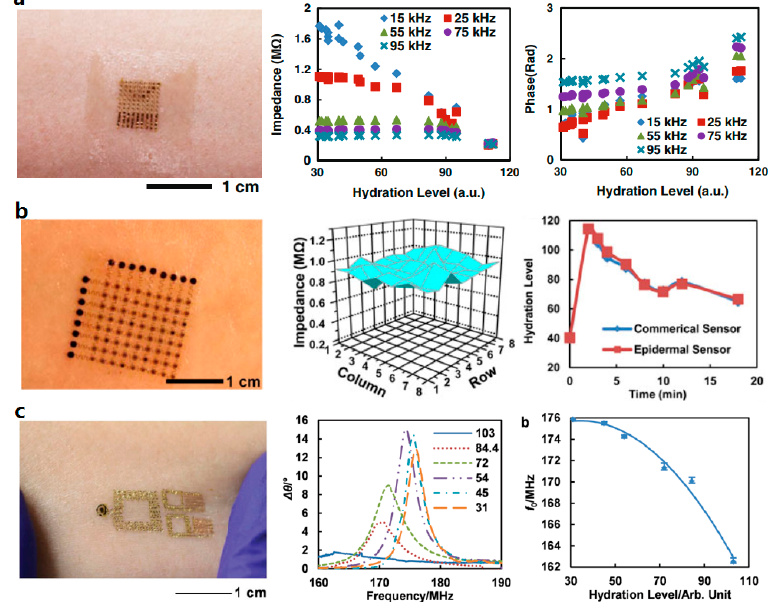
Figure 8. Examples of skin sensors used for hydration sensing: ( a ) epidermal sensor that can monitor biopotential on skin using metallic meshes (Reprinted with permission from Ref. [14] Copyright 2013 John Wiley and Sons); ( b ) hydration sensor that can conduct regional mapping based on the impedance detection (Reprinted with permission from Ref. [27] Copyright 2014 IEEE); and ( c ) hydration